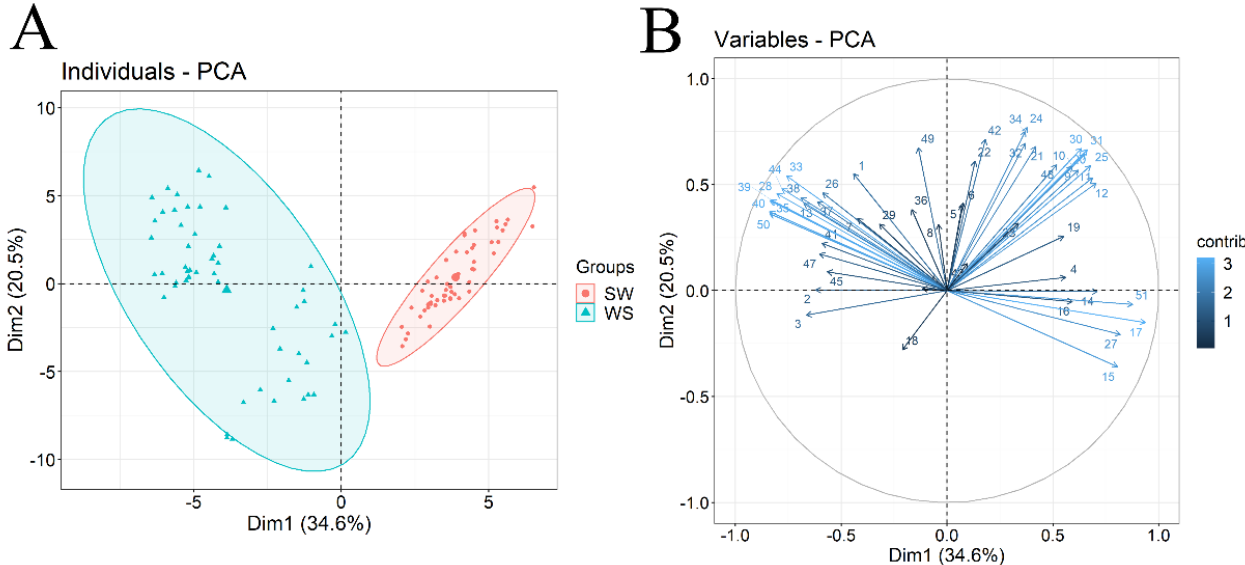
Figure 1. ( A ) Principal component analysis (PCA) scores plot and ( B ) contribution plot of volatile compounds in processed black teas. Groups: withering − shaking (WS) and shaking − withering (SW).